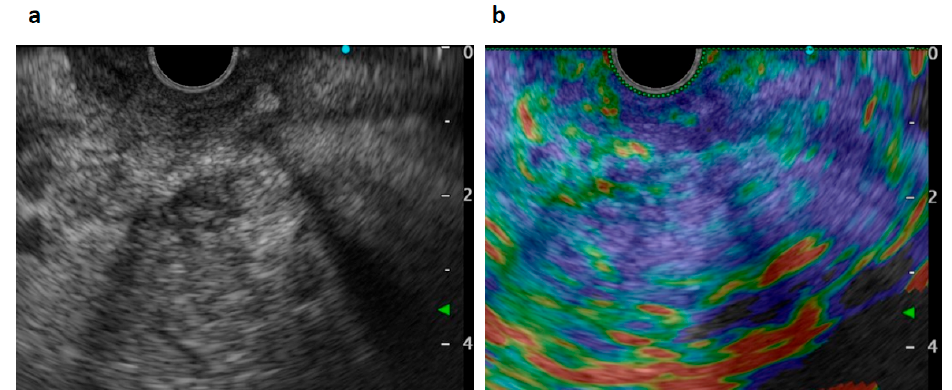
Figure 3. Endoscopic ultrasonography (EUS) views. A heterogeneous low-echoic mass was seen by scanning from the duodenal bulbs ( a ). Elastography showed a heterogeneously hard mass lesion at the pancreas head ( b ).